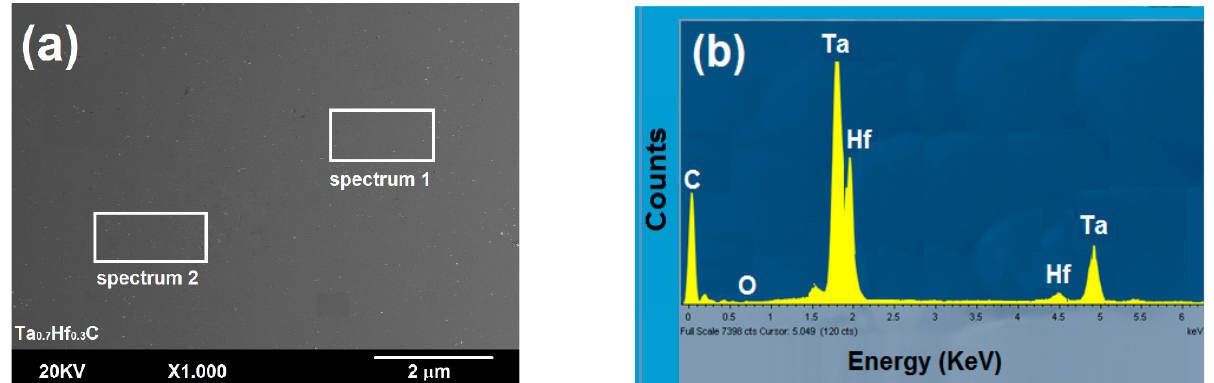
Figure 6. SEM surface micrograph ( a ) and EDS spectrum ( b ) for HfC coating.